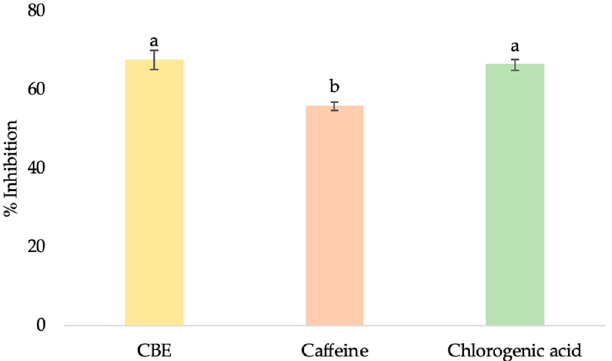
Figure 7. 5 α -reductase inhibition of CBE, caffeine, and chlorogenic acid at maximum nontoxic concentration. Data with different lower-case letters (a and b) indicate significant differences ( p < 0.05) between samples.